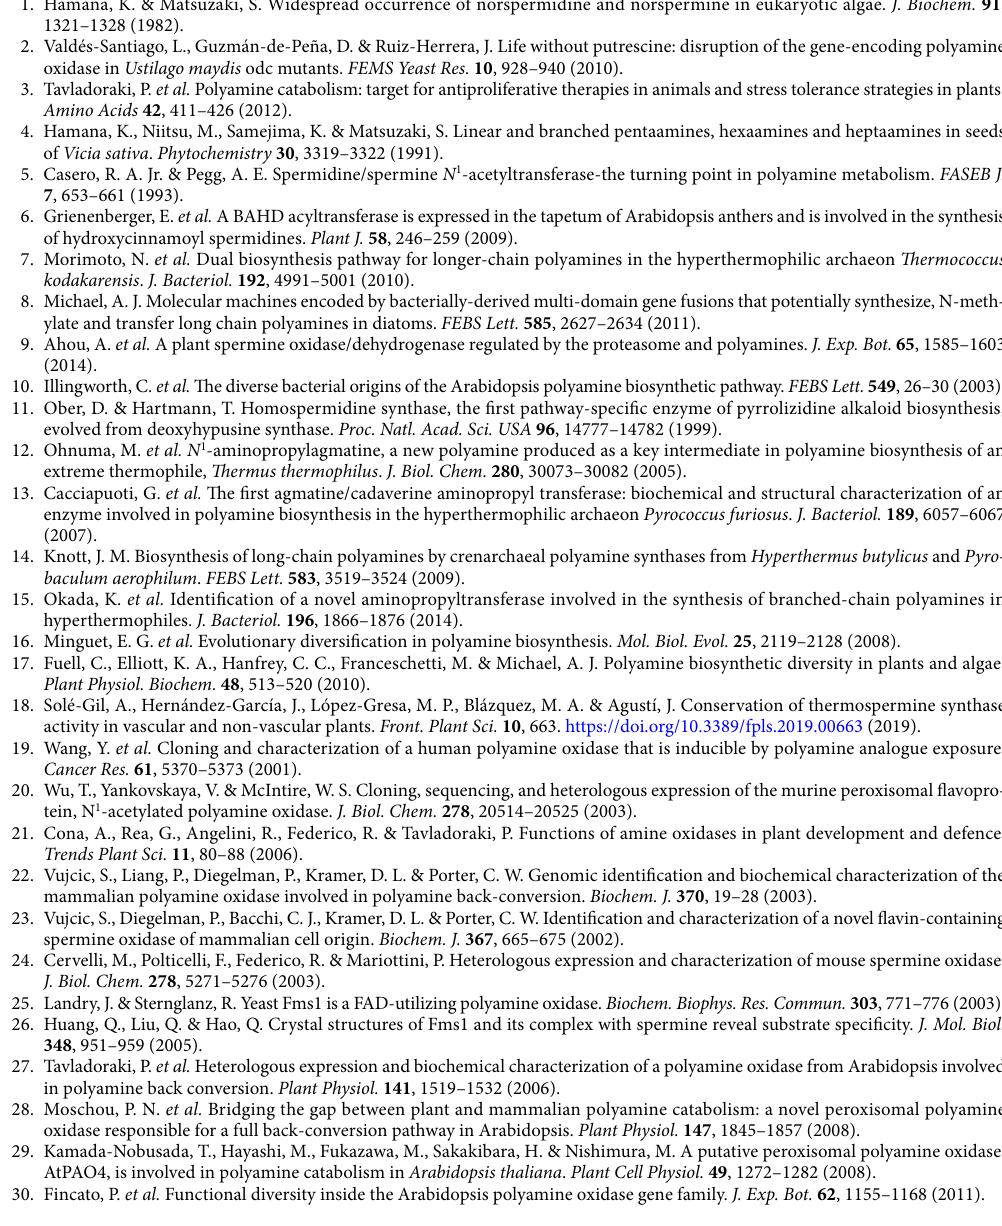
Supplementary Table S3. For each dataset the best-fit model of amino acid replacement was selected by ModelTest-NG 0.1.5 73 , using an optimize Maximum-Likelihood topology and branch lengths for each model ( -t ml ) and the Akaike Information Criterion (AIC). The WAG model 74 with gamma distributed rates across site (+ G) and a proportion of invari- ant sites (+ I) was selected for the eukaryote dataset, and the JTT model 75 with gamma distributed rates and a proportion of invariant sites (+ I) was selected for each plant PAO dataset. ML tree searches were performed with IQ-tree 76 (for dataset larger than 200 sequences) and PhyML 3.0 77 (for dataset smaller than 100 sequences) using the best-fit model and 100 random starting trees. Node support for the resulting phylogenetic tree was evalu- ated by 1000 bootstrap replicates in IQ-tree (using both the ultrafast bootstrap approximation and the SH-like approximate likelihood ratio test) and by 100 bootstrap replicates in PhyML. Phylogenetic analyses were carried out on the T-REX webserver 78 and the CIPRES Science Gateway 3.3 79 (at https ://www.phylo .org/). Code availability GenBank accession numbers of all sequences used in this study are reported in